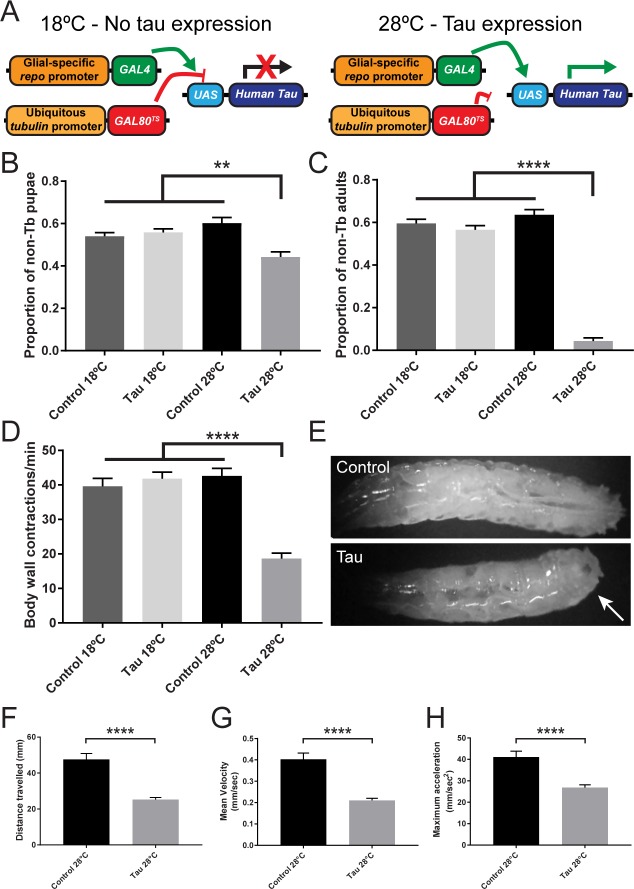
Glial tau expression during development is lethal and causes larval motor deficits.(A) Schematic depicting temperature-sensitive control of GAL4/UAS-driven tau expression by ubiquitous expression of a temperature-sensitive allele of GAL80 (GAL80TS). At 18°C, glial-specific, GAL4-mediated tau expression is repressed by GAL80TS, while at 28°C, GAL80TS is unable to repress GAL4 and glial-specific tau expression is achieved. (B) Proportion of pupae that lack the TM6B,Tb balancer (non-Tb) from control and glial tau transgenic crosses at 18°C and 28°C. (n = 3–4 crosses; 347–916 pupae; ** p < .01, **** p<0.0001, Kruskal-Wallis with Dunn’s multiple comparison). (C) Proportion of eclosed adults lacking the TM6B,Tb balancer from control and glial tau transgenic crosses at 18°C and 28°C. (n = 3–4 crosses; 205–628 adults; **** p<0.0001, Kruskal-Wallis with Dunn’s multiple comparison). (D) Body wall contractions of control and glial tau transgenic larvae from crosses performed at 18°C and 28°C. (n = 20–30; **** p<0.0001, One-way ANOVA with Tukey’s multiple comparison). (E) Representative light microscopic image of normal control larva and glial tau transgenic larva with dystonic, curled posterior (arrow). (F-H) Larval motility parameters were analyzed with Ethovision during 2 minute trials. (F) Total distance travelled, (G) mean velocity, and (H) maximum acceleration were analyzed from control and glial tau transgenic larvae from crosses performed at 28°C. (n = 20; **** p<0.0001, Mann-Whitney) Error bars represent SEM.